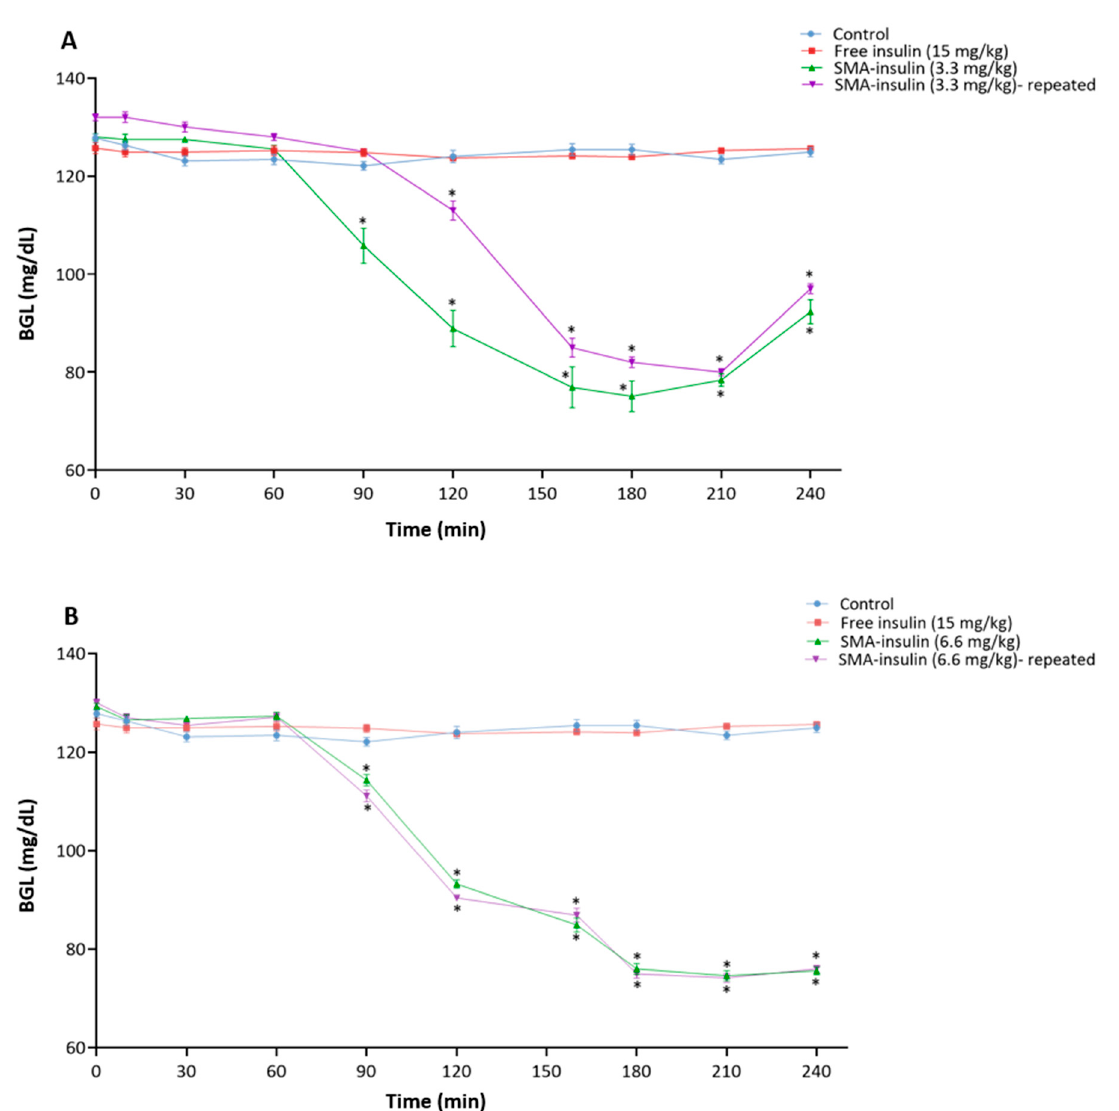
Figure 6. Blood glucose profiles of healthy mice following oral administration of SMA-insulin micelles and insulin. Mice ( n = 10 per group) were fasted overnight before oral gavage with water, insulin (15 mg / kg) and either ( A ) SMA-insulin (3.3 mg / kg) single or repeated dosing (24, 48 and 72 h) or ( B ) SMA-insulin (6.6 mg / kg) single or repeated dosing (24, 48 and 72 h). The BGL was measured for 4 h using a glucometer. Data are represented as mean ± SD ( n = 10). The mean of BGL was analyzed using a one-way ANOVA. * p < 0.05 denotes statistical significance.